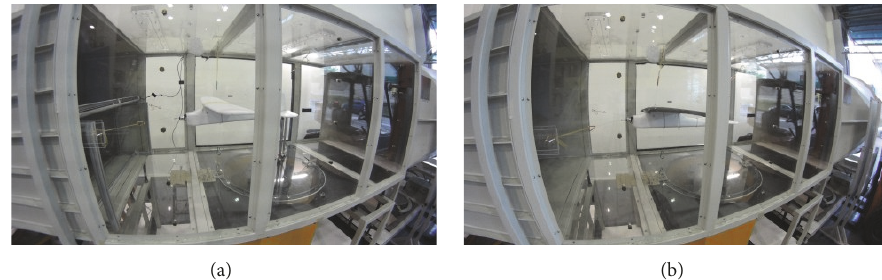
Figure 13: Test rigs: (a) the rigid wing and (b) the FMW model, suspended in the middle of the test section of the wind tunnel.